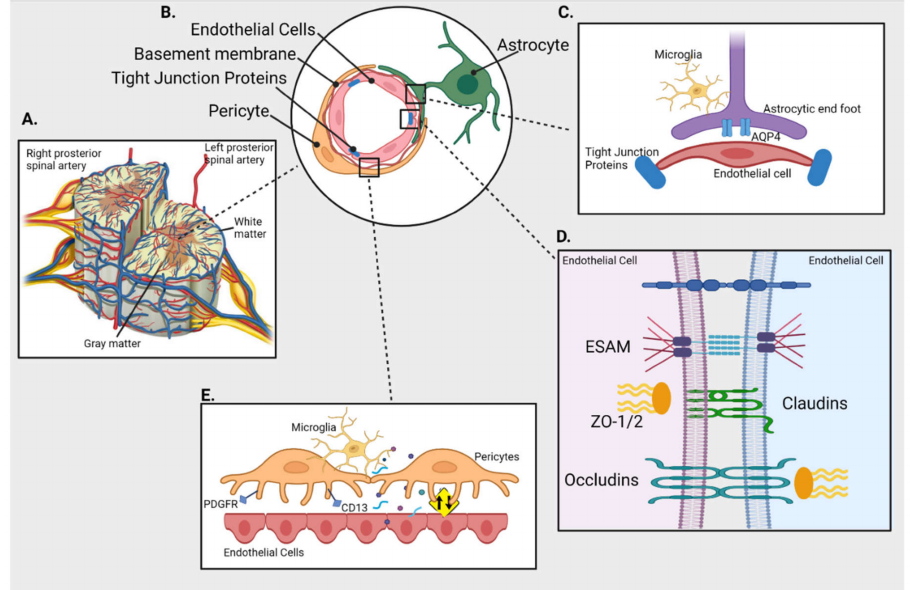
Figure 1. Blood-spinal cord barrier (BSCB) and its cellular components. ( A ) Cross section of spinal cord and its blood supply ( B ) Schematics of cellular components of BSCB; endothelial cells (ECs) are separated from pericytes by basement membrane and held together by tight junction proteins (TJs); astrocytes connect with both pericytes and ECs ( C ) Inset shows interaction between the astrocytic end foot enriched with aquaporin 4 (AQP4) and ECs in presence of immune cells (microglia) ( D ) Inset shows TJs like endothelial cell-selective adhesion molecule (ESAM), claudins, occludins and Zonula occludens (ZO-1) holding the ECs together ( E ) Inset represents interaction between ECs and pericytes (expressing PDGFR and CD13) that plays an important role in maintaining the integrity of BSCB by regulating the uptake of circulating macromolecules (presented as yellow